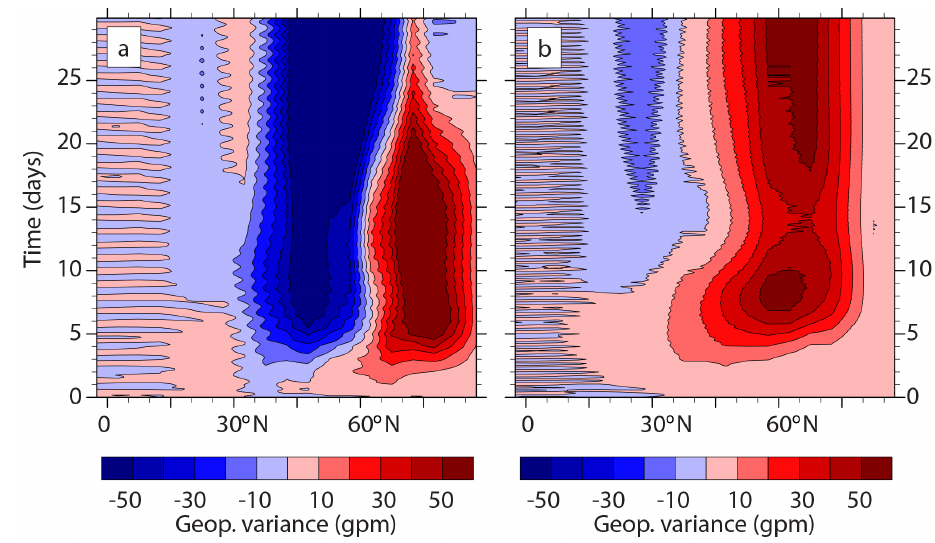
Figure 10. Time evolution of a wave-1 (a) and wave-3 (b) amplitude difference with respect to the reference run, as given by the FT of geopotential height at approx. 35km log-pressure height for Box0.1 simulation. Units are given in (gpm).